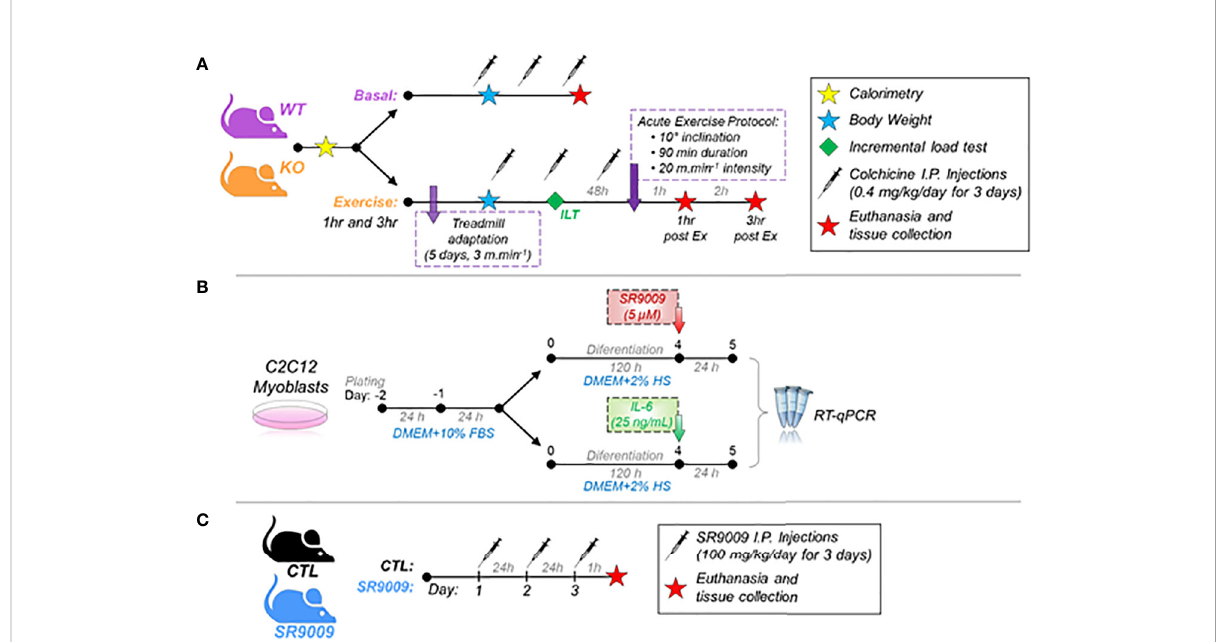
FIGURE 1 A schematic diagram of the experiments. (A) Experimental design of WT and IL-6 KO mice at basal and 1hr and 3hr post-exercise. A different batch of mice received colchicine I.P injections; (B) Experimental design of C2C12 myoblasts treated with SR9009 or IL-6; (C) Experimental design of CTL and SR9009 administration in mice. WT, wild-type mice; IL-6 KO, interleukin 6 knockout mice; CTL, control